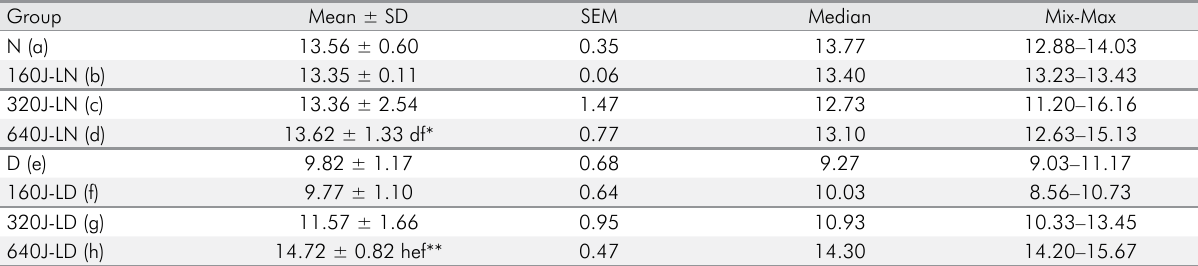
Table 2. Quantity of immune-positive osteocytes for Osteopontin (mean ±